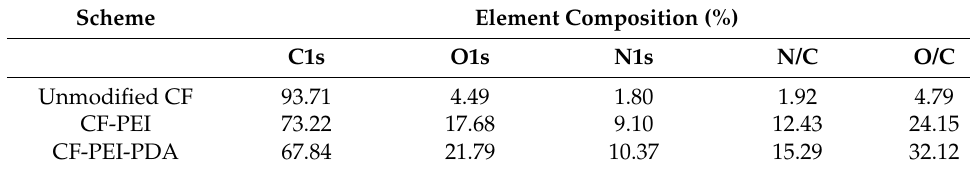
Table 2. Surface element analysis of different carbon fibers.